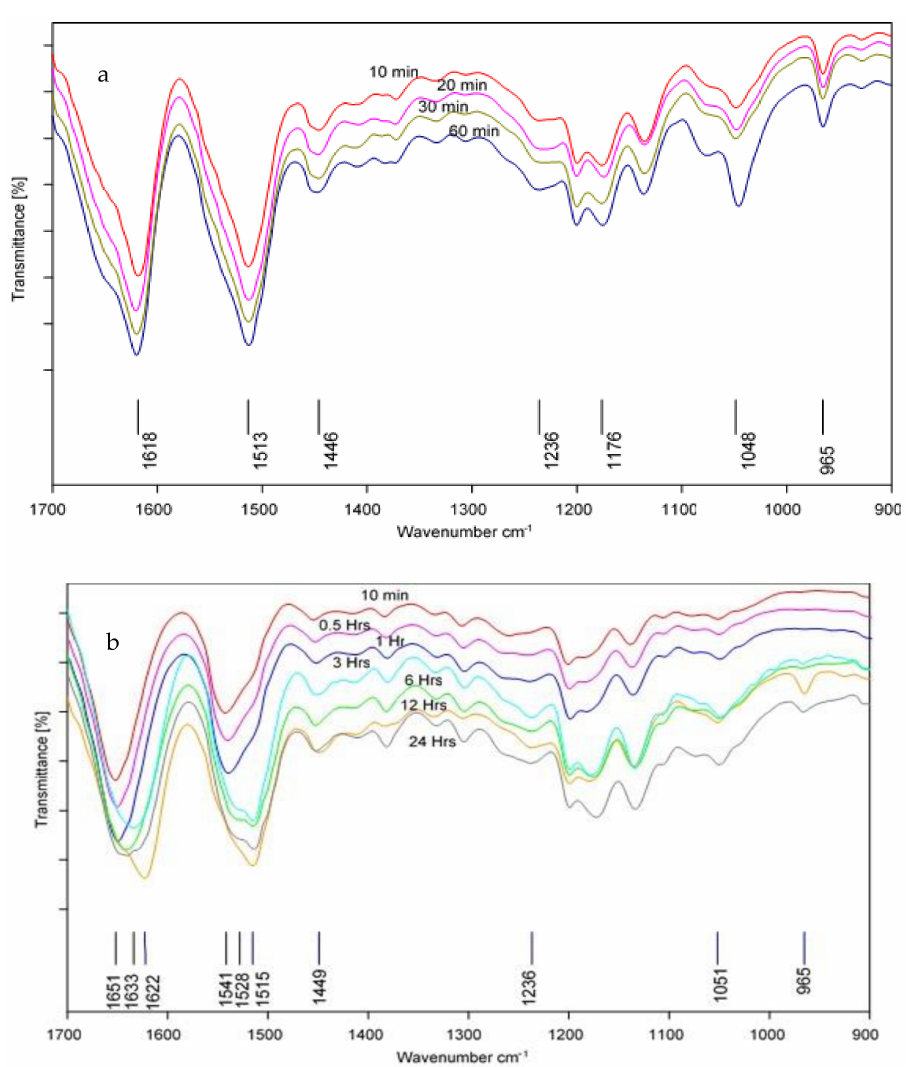
Figure 18. FTIR Spectra of ( a ) methanol and ( b ) water vapor annealed